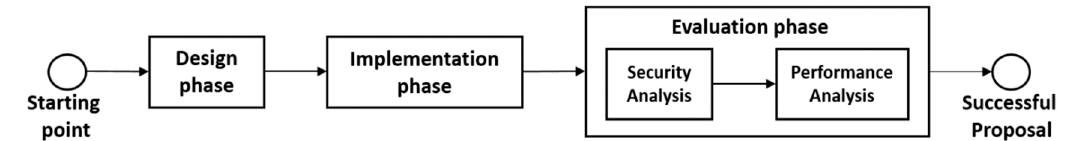
Figure 7. Proposal Figure 7. Proposal roadmap.